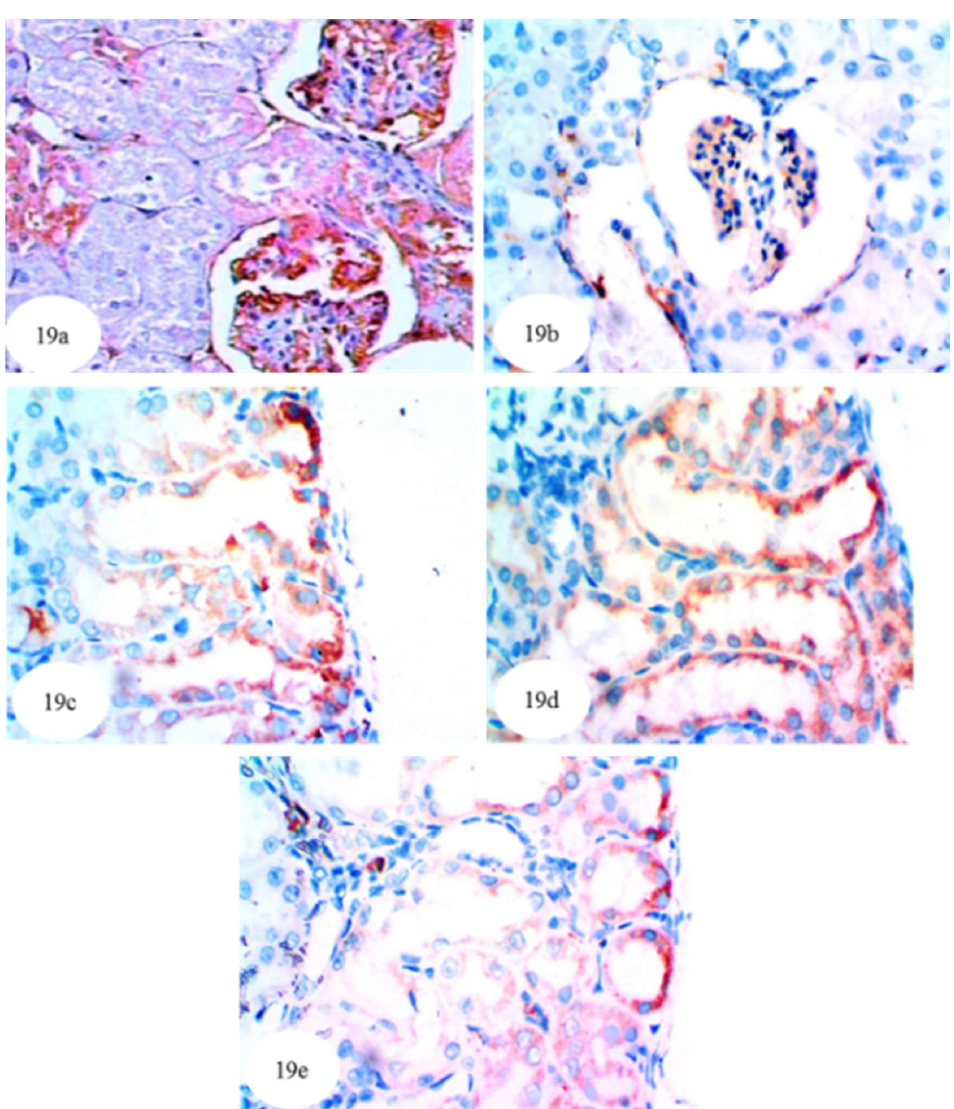
Figure 19. Photomicrographs of immunohistochemically stained kidney sections showing the lighter amount of the antiapoptotic marker Bcl-2 (yellowish brown color) in the cytoplasm of the urolithic rats ( b ) (×512) as compared with normal control group ( a ) (×512). Bcl-2 was potentially increased after treatment of ethylene glycol-administered rats with P. ostreatus ( c ) (×512), A. bisporus ( d ) (×512) and carvedilol ( e ) (×512), which was indicated by increase of intensity of the yellowish brown color. 3.14. E ff ect on Kidney p65, p50, Bax and Bak Detected by Western